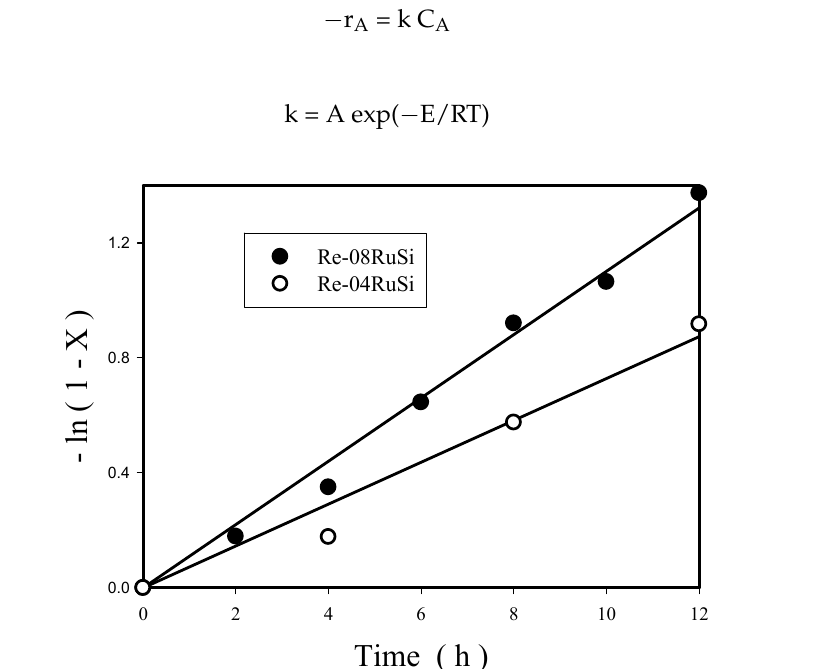
Figure 11. Test of pseudo-first-order kinetic model for Re-04RuSi and Re-08RuSi catalysts at 130 °C and 800 psig.